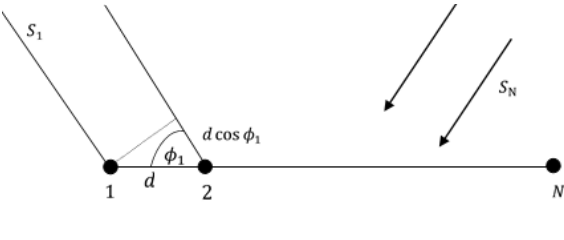
Fig. 2. Illustration of uniform linear array (ULA) Array factor (AF) is a factor in the array antenna which is related to the number of elements and phases difference between elements produced by the inter-element distance. If the inter-element distance is uniform, denote by 𝑑 , and the number of antenna elements is 𝑁 , the expression of the AF of linear array in receiver side which laid in 𝑥 axis is [20]